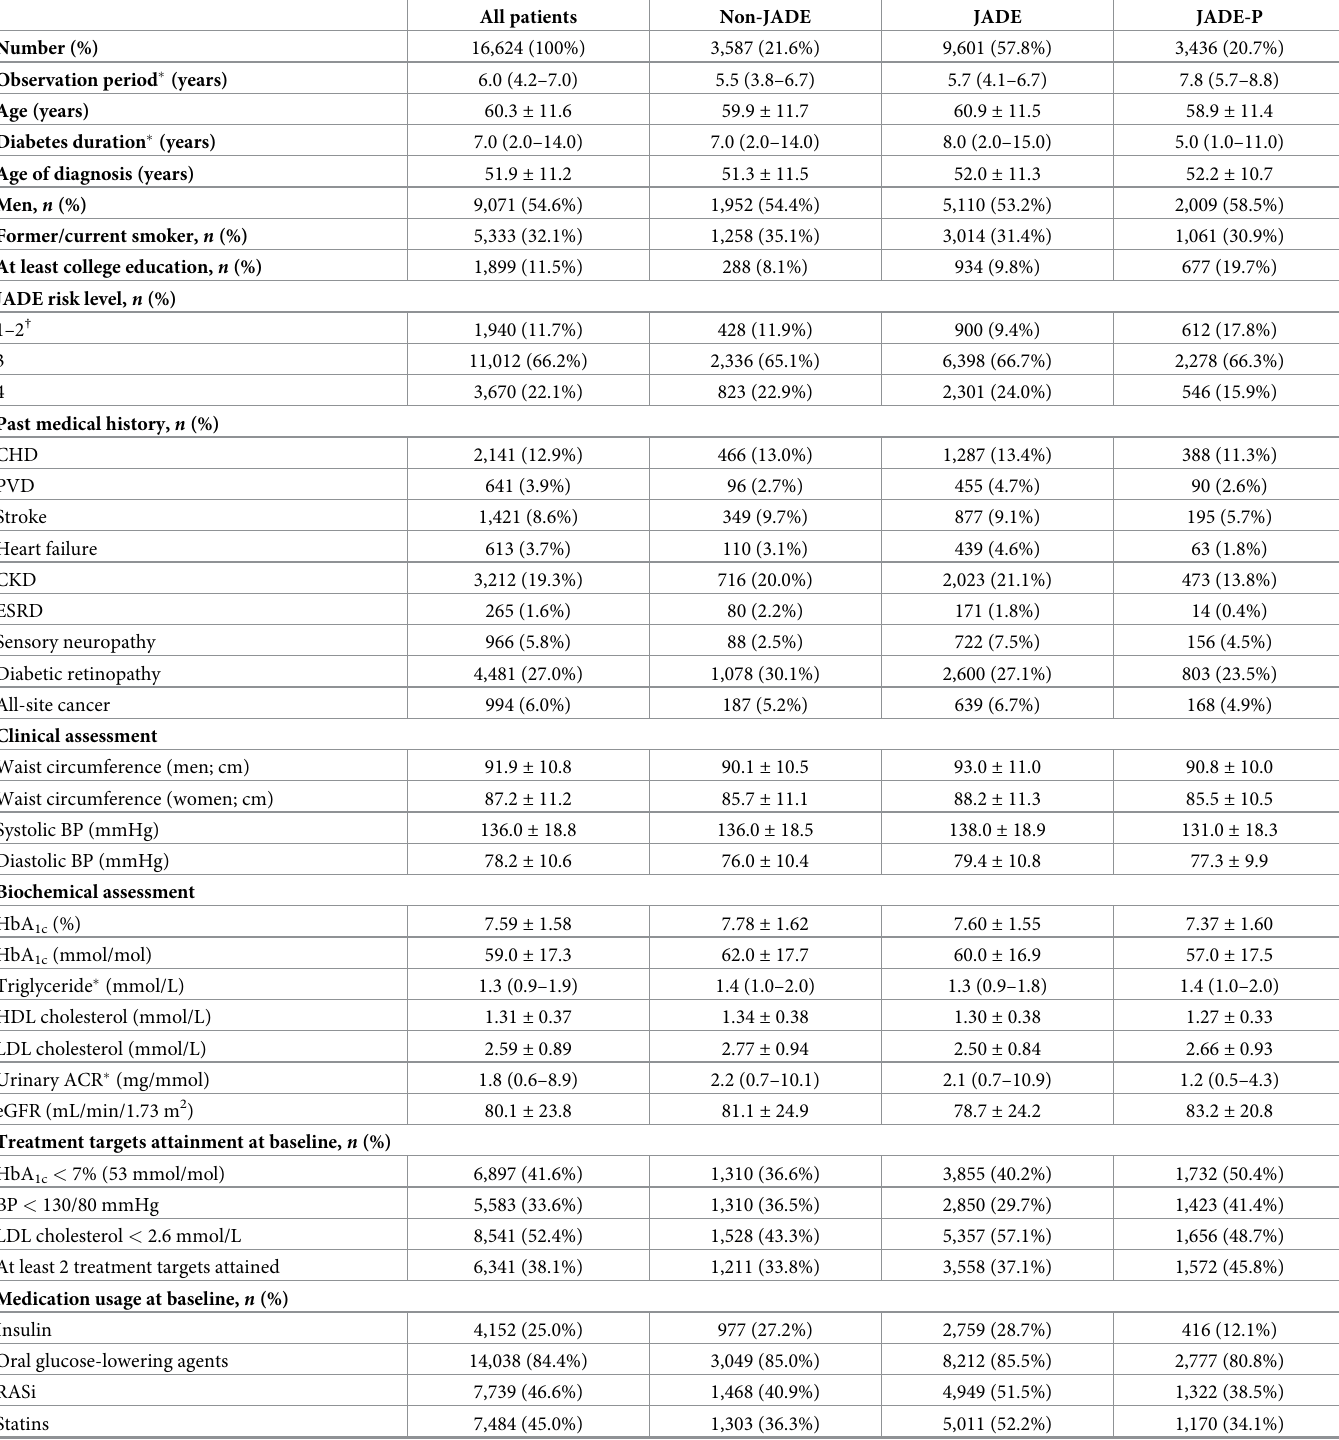
Table 1. Baseline characteristics of patients with type 2 diabetes categorized by 3 care settings: (1) non-JADE group (publicly funded evaluation), (2) JADE group (publicly funded evaluation with JADE report and group education), and (3) JADE-P group (self-paid evaluation with JADE report, personalized empowerment, and annual telephone reminder for